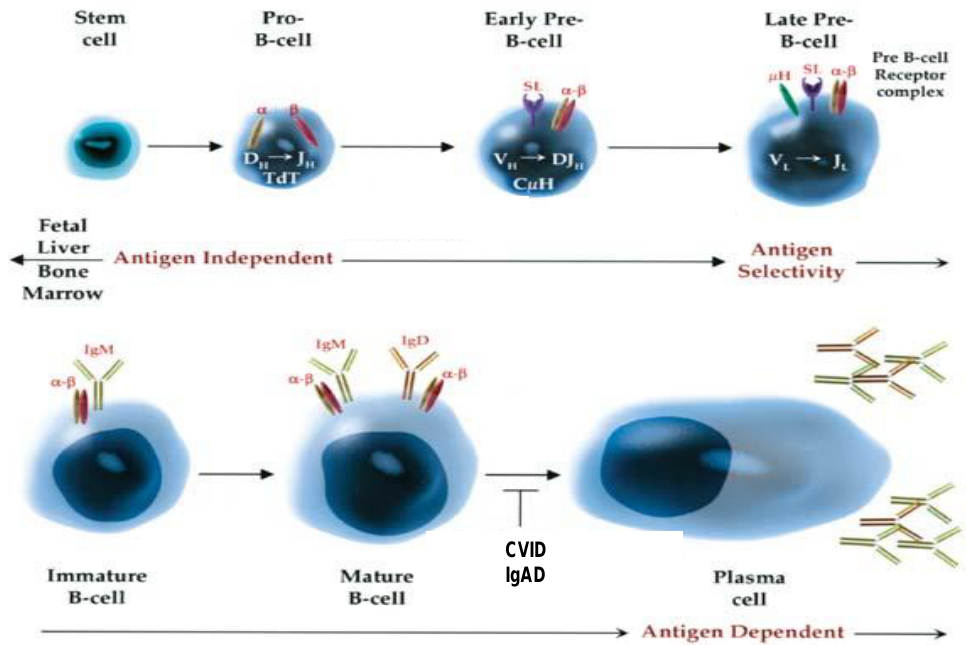
Figure 1A: B Figure 1A: B cell development and cell development and aa putative step involved putative step involved CVIDCVID developmentdevelopment